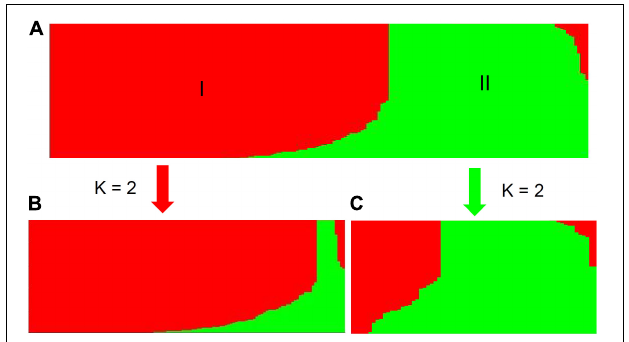
FIGURE 2 | Population structure of the whole accession panel and the two subspecies inferred from STRUCTURE analysis. The whole panel (A) was divided into two main groups (I and II). Each of the two subspecies, melo accessions (B) and agrestis accessions (C) , was further subdivided into two subgroups, where K = 2.